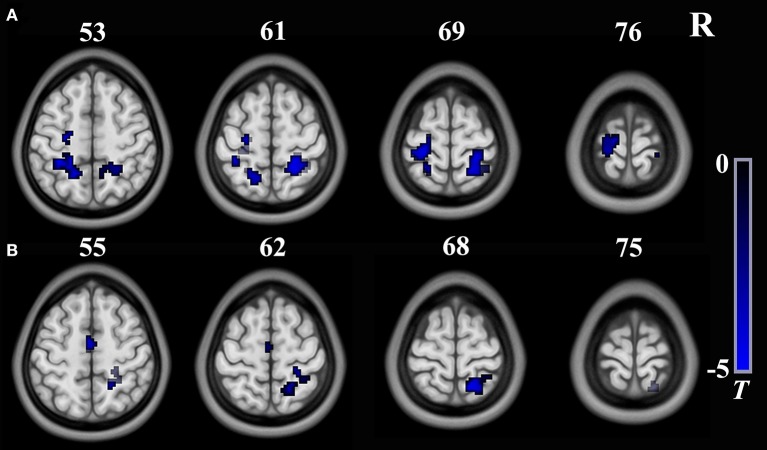
Brain regions show significant intergroup differences in seed-based FC. (A) The seed is the right insula from long-range rsFCS comparison; (B) The seed is theright supermarginal gyrus from short-range rsFCS comparison. The color regions represent decreased FC in patients. The color bar indicates the T-value from two-sample t-tests. FC, functional connectivity; rsFCS, resting state functional connectivity strength.